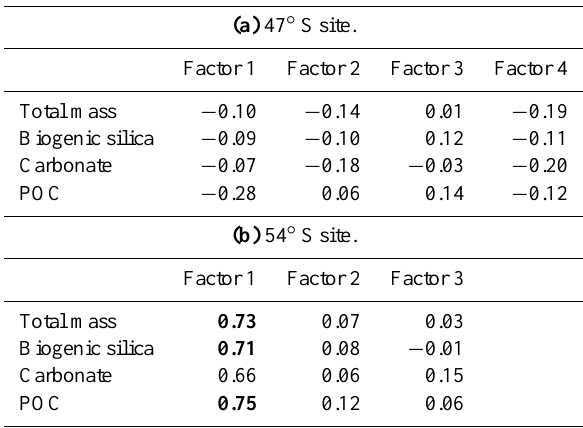
Table 6. Correlation coefficients between the PCA factors and the fluxes of bulk components (total mass, carbonate, biogenic silica and POC) for the 47 ◦ S (a) and 54 ◦ S (b)